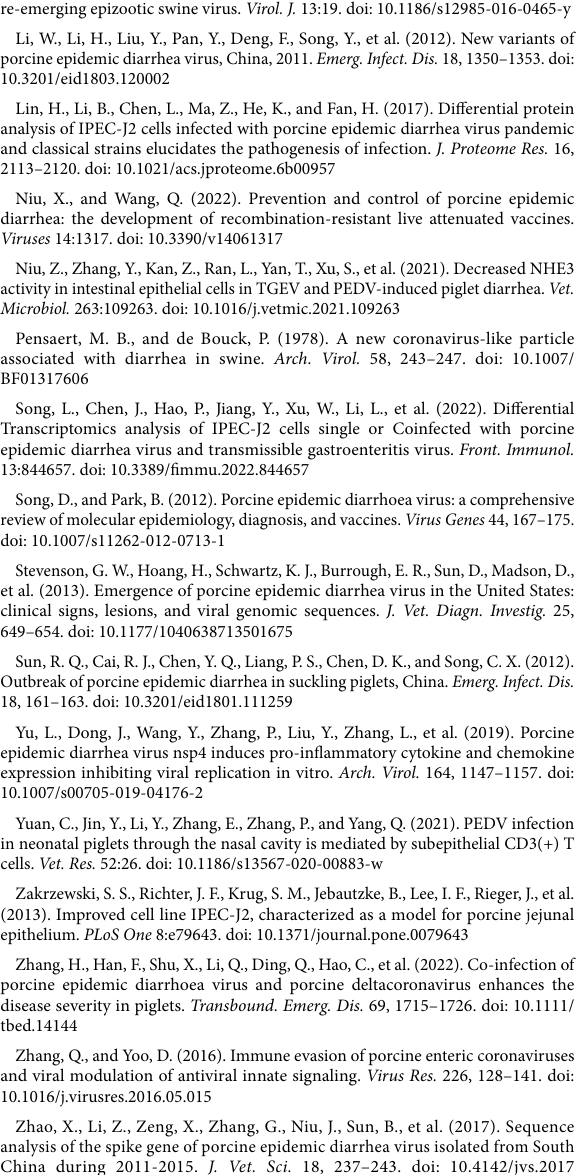
SUPPLEMENTARY FIGURE S1 Polymerase chain reaction (PCR) detection of PEDV N gene in mucus of the small